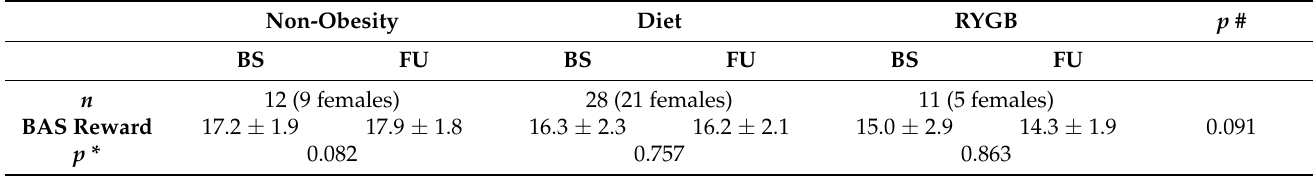
Figure 7. Relationship between 5-HTT BP ND at baseline and ∆ BMI in the dorsal raphe nucleus (DRN) in the RYGB surgery group ( A ) and in the diet group ( B ). Table 4. BAS reward responsiveness of study participants before (baseline, BS) and after 6 months of intervention (follow-up, FU).